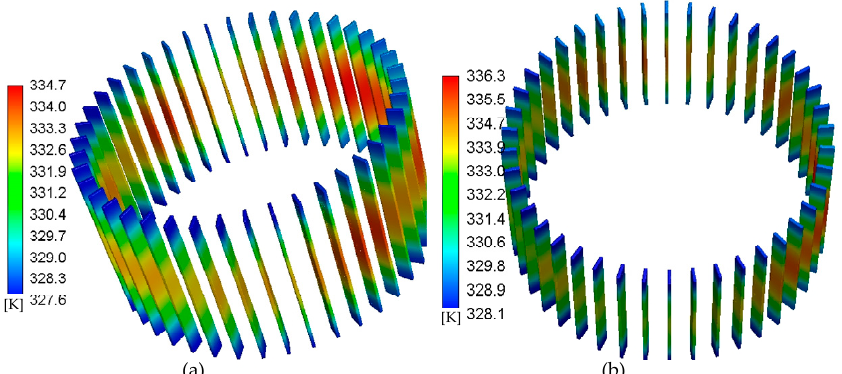
Figure 7. Winding temperature distribution. ( a ) Unidirectional coupling; ( b ) bidirectional coupling.